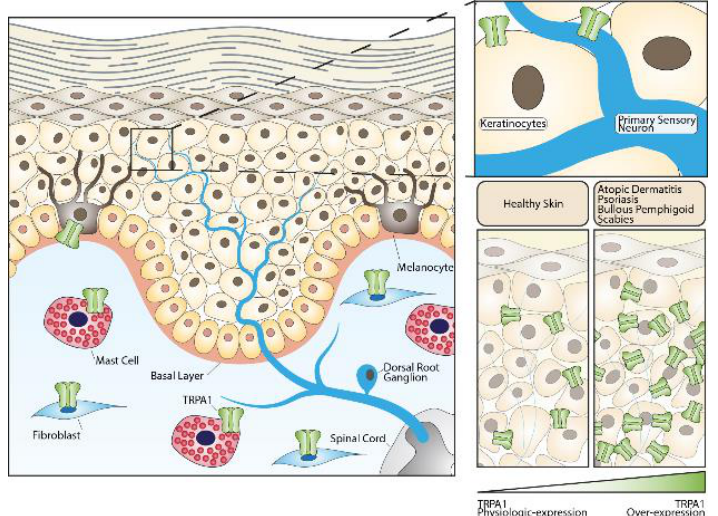
Figure 1. Role of the TRPA1 channel in skin homeostasis and skin diseases. TRPA1 channels expressed in sensory fibers innervating the skin or in different non-neuronal cells can either contribute to maintaining normal skin physiology or play important roles in the pathogenesis of skin diseases.